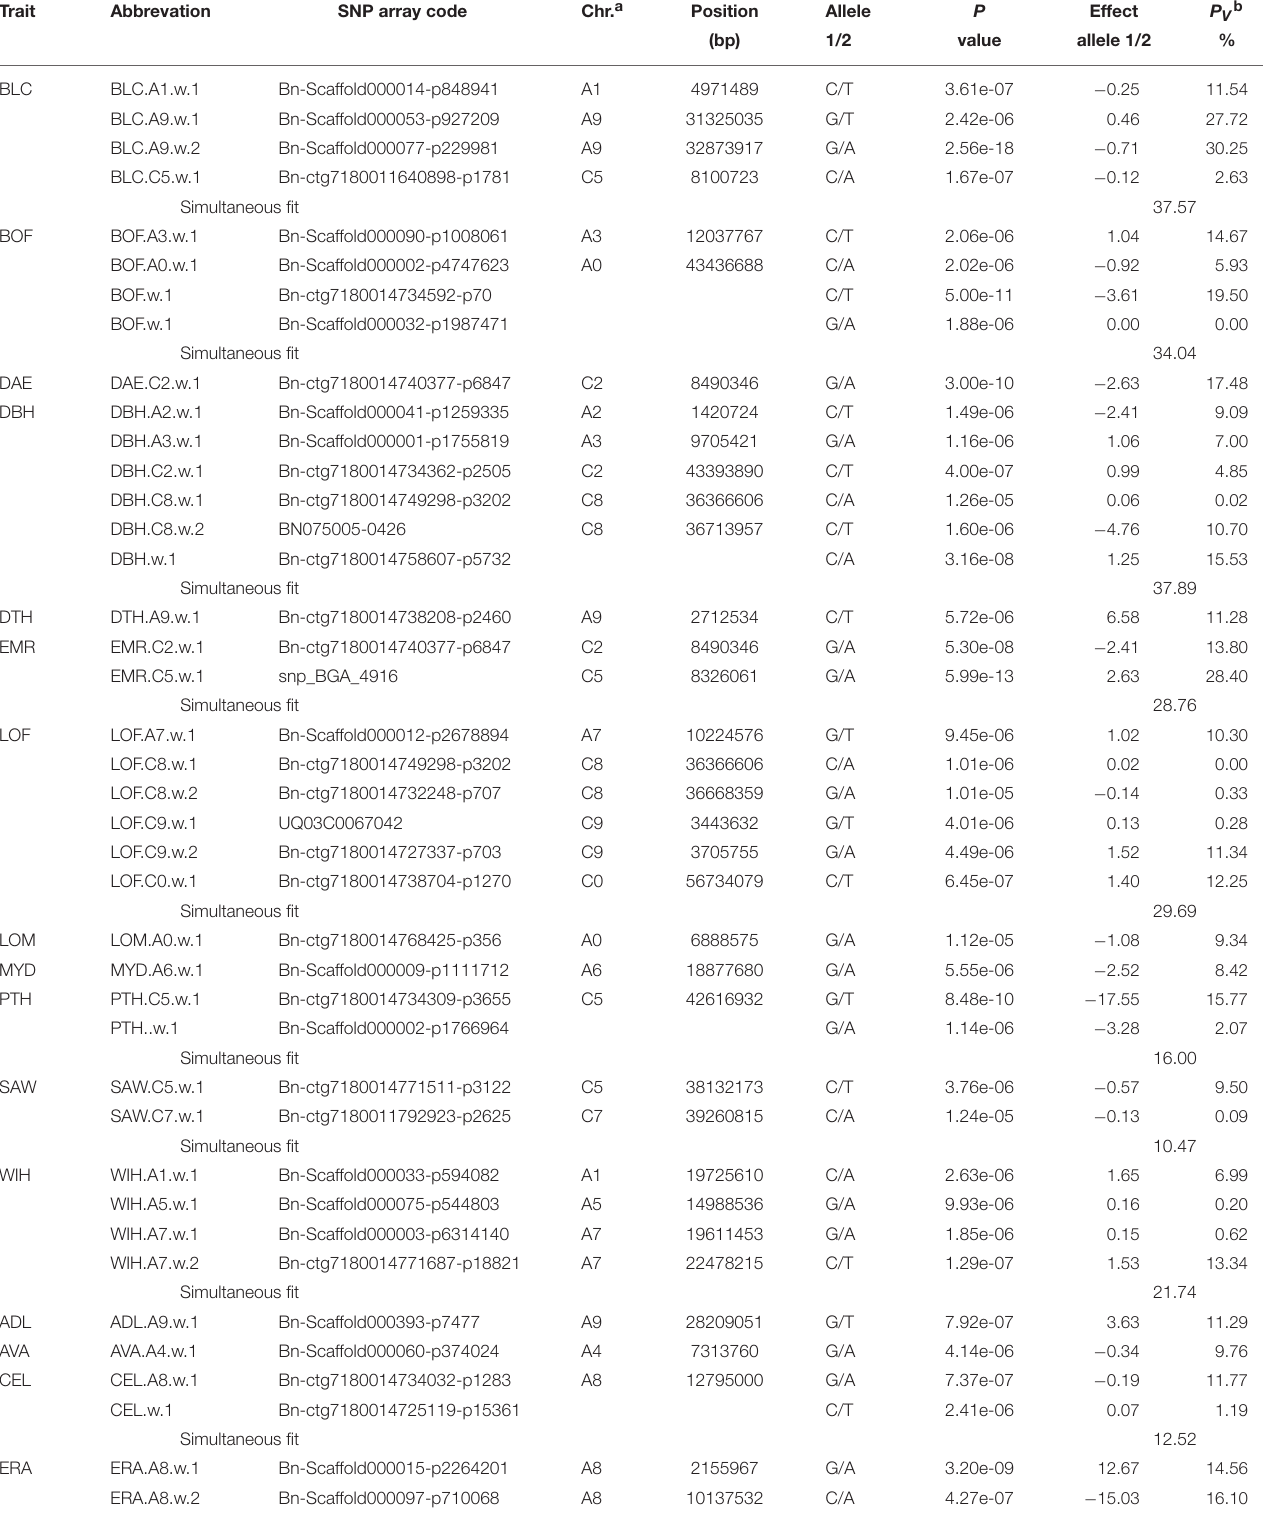
TABLE 3 | Single nucleotide polymorphism (SNP)-trait associations with P < 1.28e-05 (Bonferroni correction of α = 0.05) across the 214 inbreds of the winter trial.